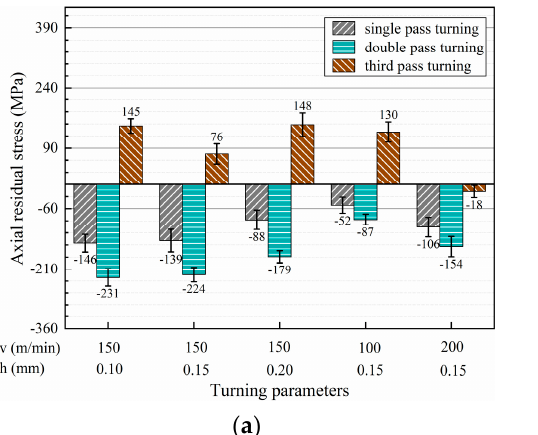
Figure 7. Surface residual stresses under multi-pass turning conditions: ( a ) surface residual stress in the axial direction and ( b ) surface residual stress in the radial direction.